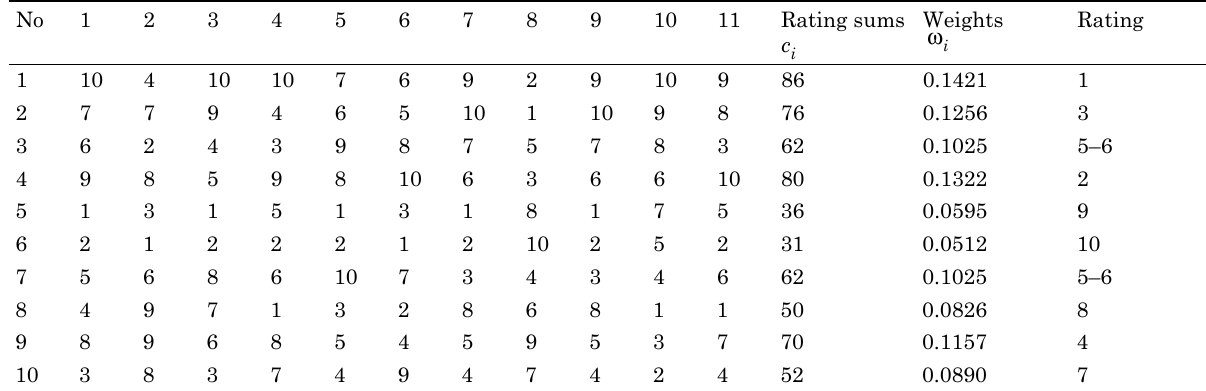
Table 3. Modified rating table of subjective